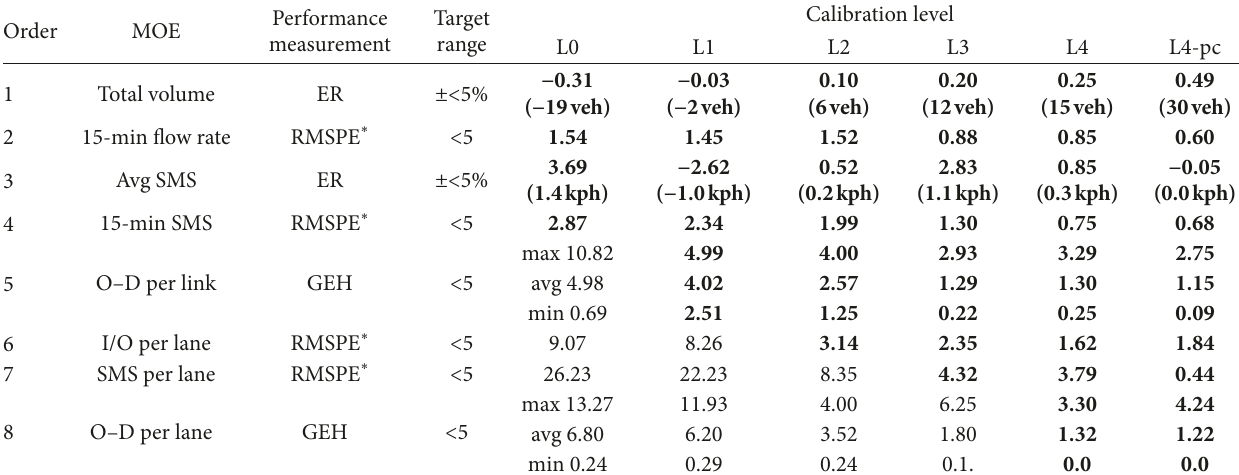
Cells with bold text: calibration achieved.